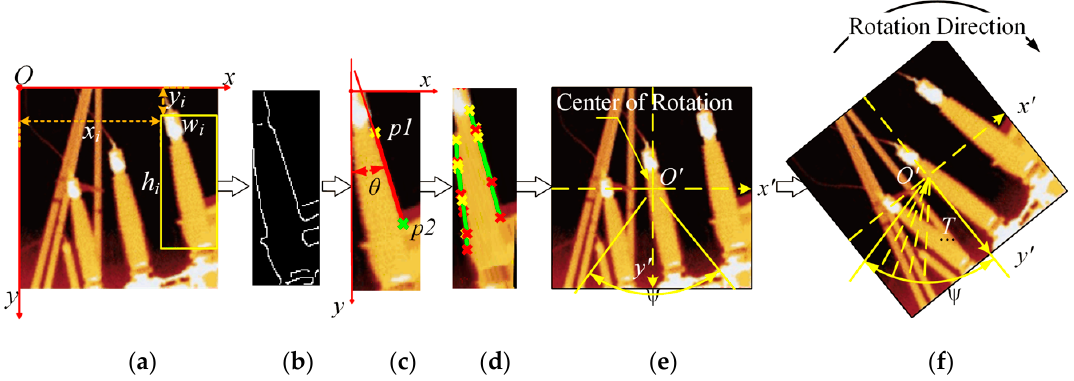
Figure 3. Schematic diagram for obtaining the optimal recognition angle; ( a ) recognition results of the YOLOv2 network; ( b ) extraction of image edges by Canny; ( c ) detection of straight line in the image by standard Hough transform (SHT); ( d ) the shape features of insulating bushing (IB); ( e ) determine ψ rotation range ; ( f ) rotate the image.